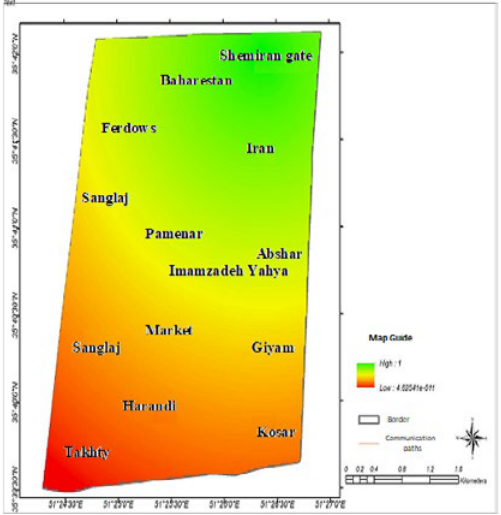
Fig. 7: Fuzzy layer of distance from Storage Centers Fig. 8: Fuzzy layer distance from urban facilities and services